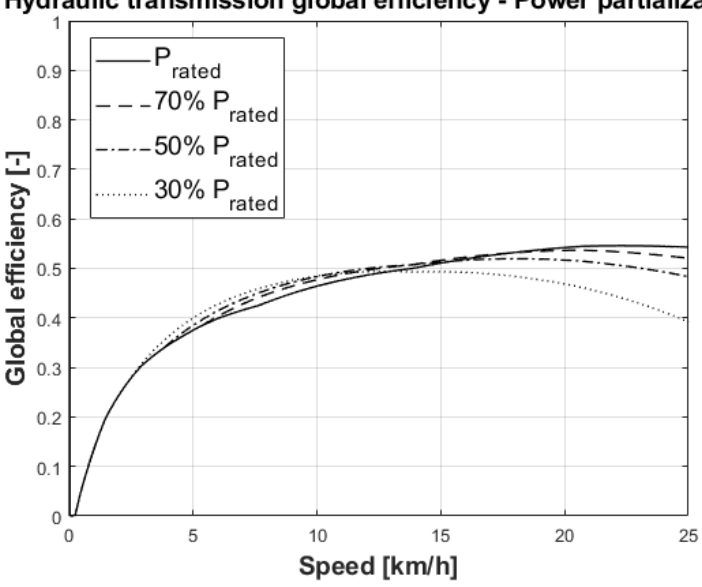
Figure 15. Hydraulic transmission global efficiency.